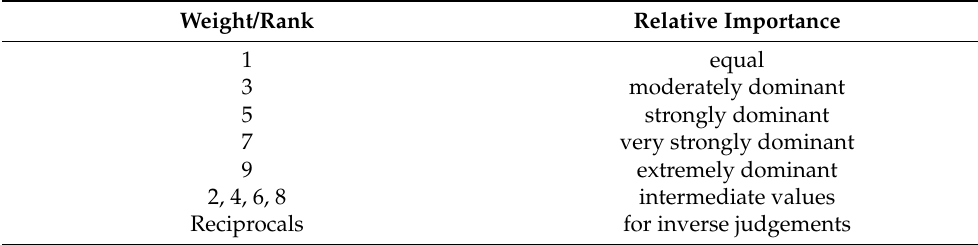
Table 1. Application of Analytical Hierarchy Process (AHP) method: relative importance for compar- ison between different alternatives